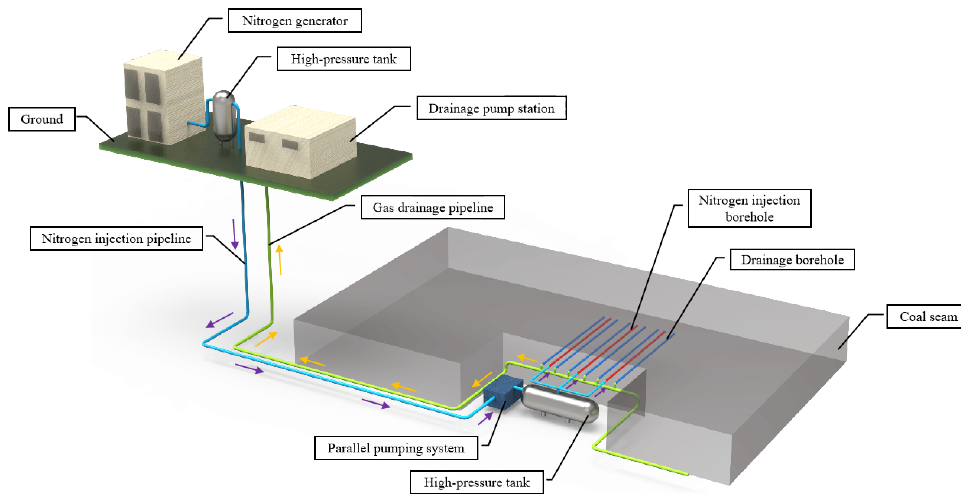
Figure 7. Schematic diagram of N 2 -ECGD test system.